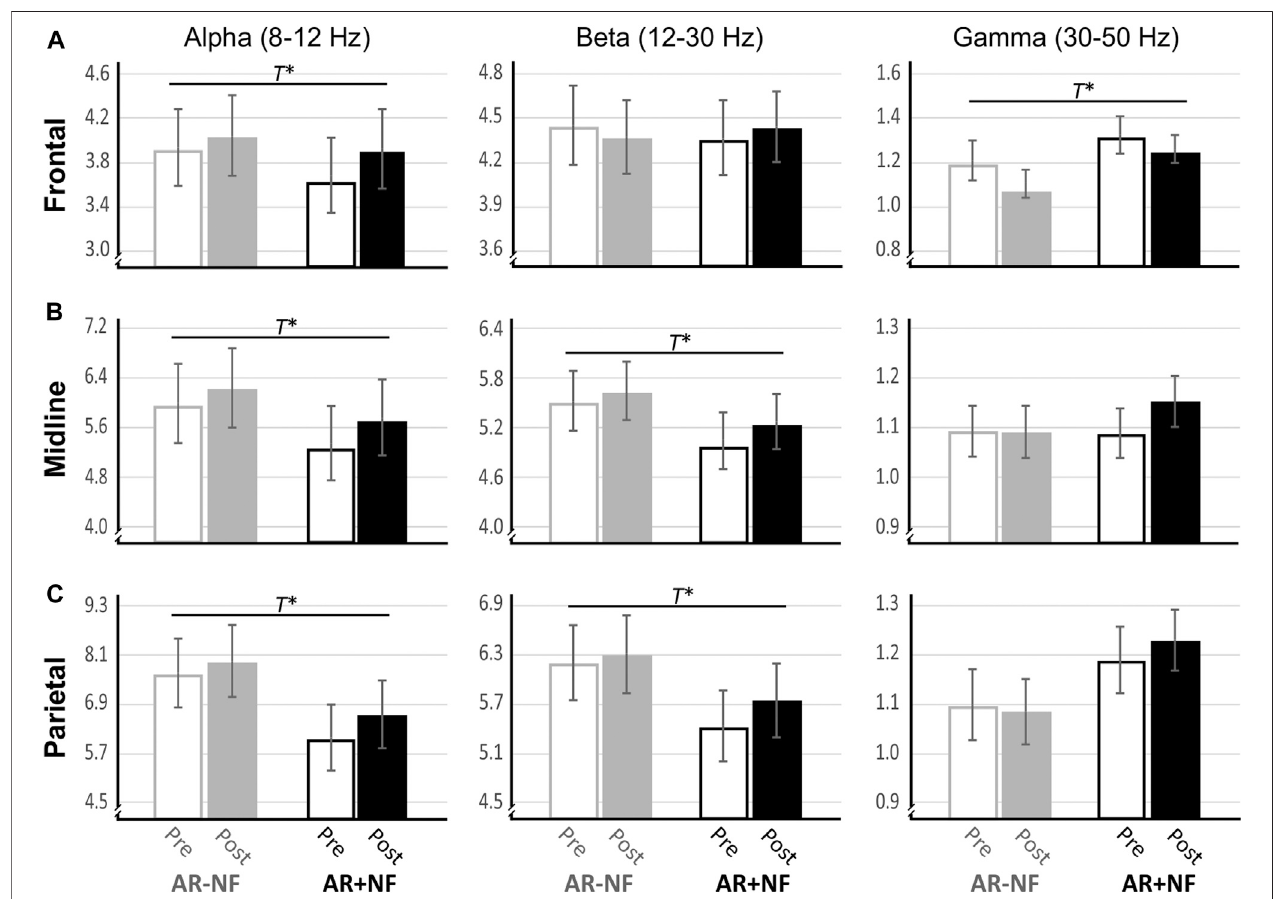
FIGURE 3 | Changes in resting state EEG after AR-guided meditation with and without neurofeedback. T* denotes signi fi cant main effect for pre-post change for both conditions. No signi fi cant between-group main effects or interactions effects occurred. Means and standard error of the means are shown. Units are mV 2 .